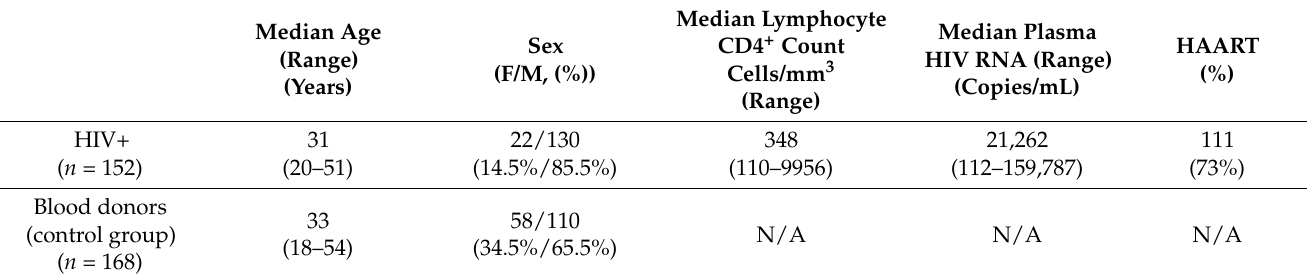
Table 1. Clinical and epidemiological characteristics of the studied